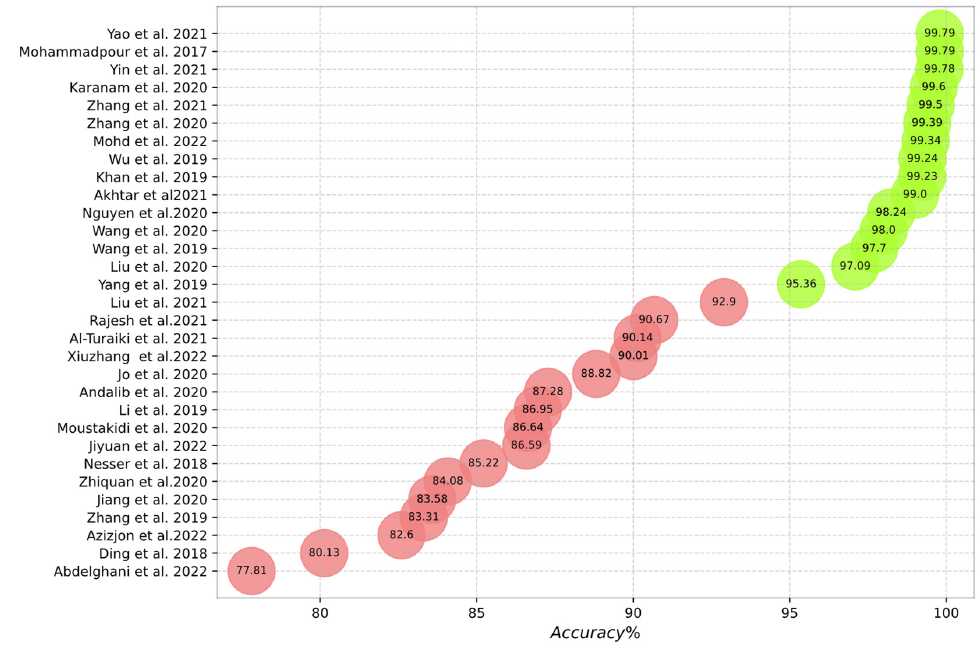
Figure 10. Accuracy of the studied schemes on the NSL-KDD dataset [3,19,20,22,24,25,28–33,35,36,38,